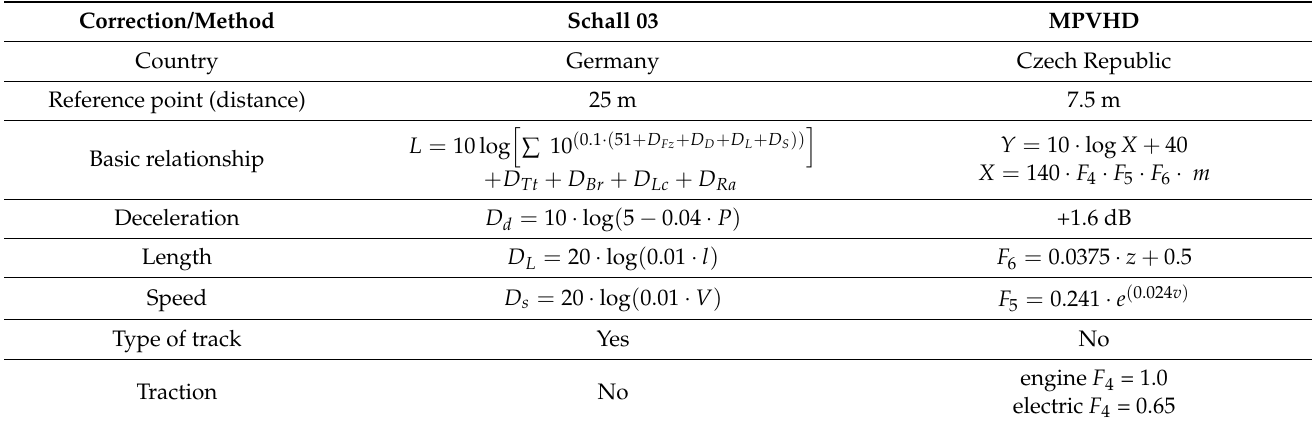
Table 1. Comparison of both prediction